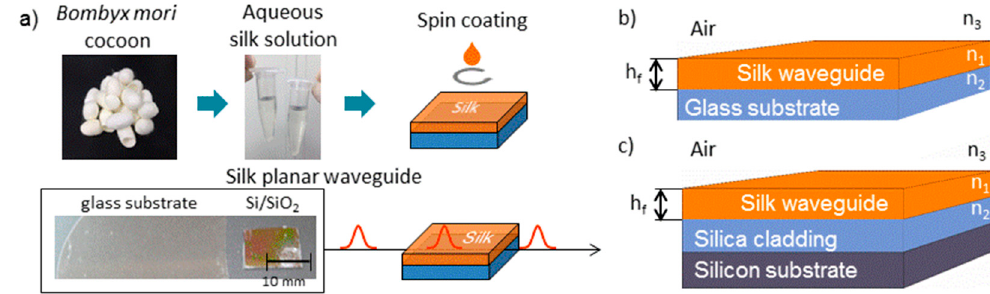
Figure 1. ( a ) A schematic view of the silk optical planar waveguide deposition procedure; ( b ) silk optical planar waveguide on glass substrate; ( c ) silk optical planar waveguide on silica-on-silicon substrate.